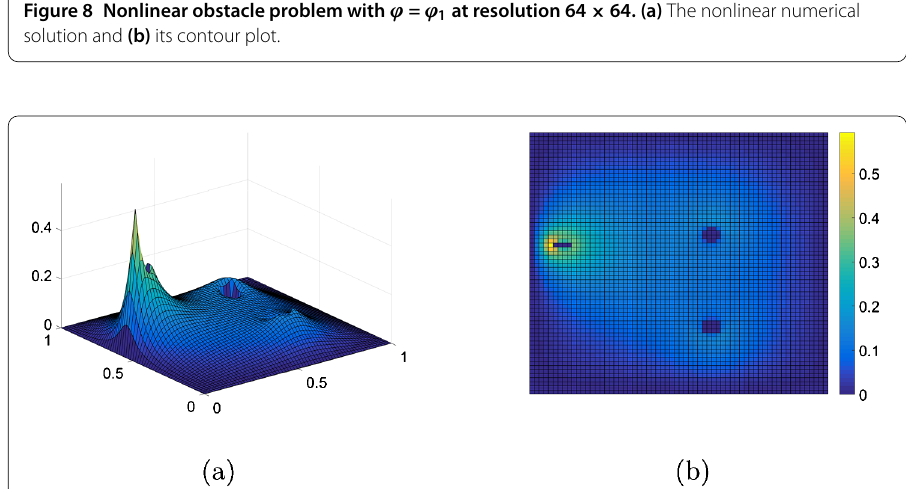
Figure 9 The difference between the linear solution and the nonlinear solution, at the 64 × 64 resolution, for the obstacle problem with ϕ = ϕ 1 . (a) ( u h ,linear – u h ,nonlinear ) and (b) its density plot.